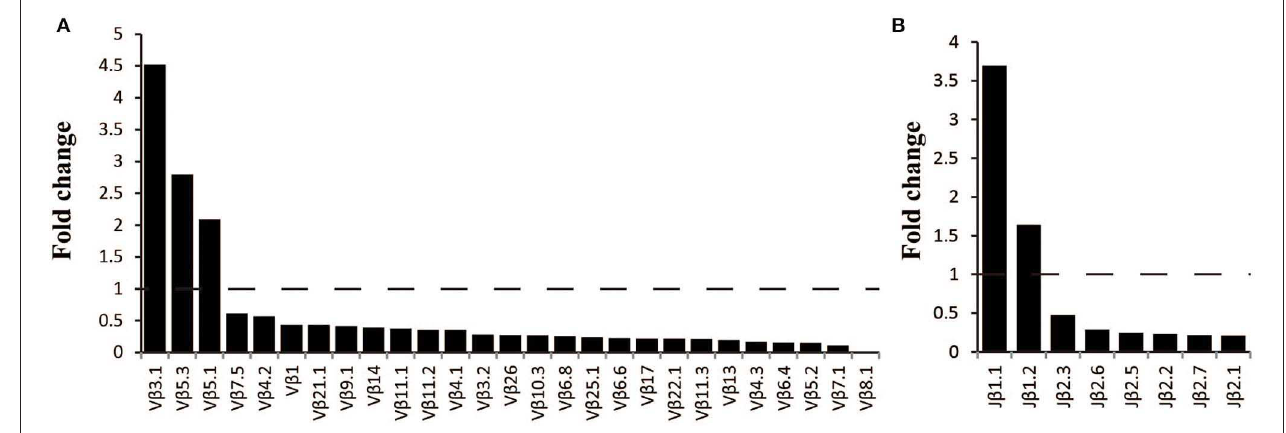
FIGURE 3 | Comparison of V β and J β gene segments used in MN patients and healthy controls. (A) A total of 27 V β gene segments and (B) 8 J β gene segments with different usage frequencies between MN patients and healthy controls (all P < 0.05). Fold change = the median frequency in MN patients divided by the median frequency healthy